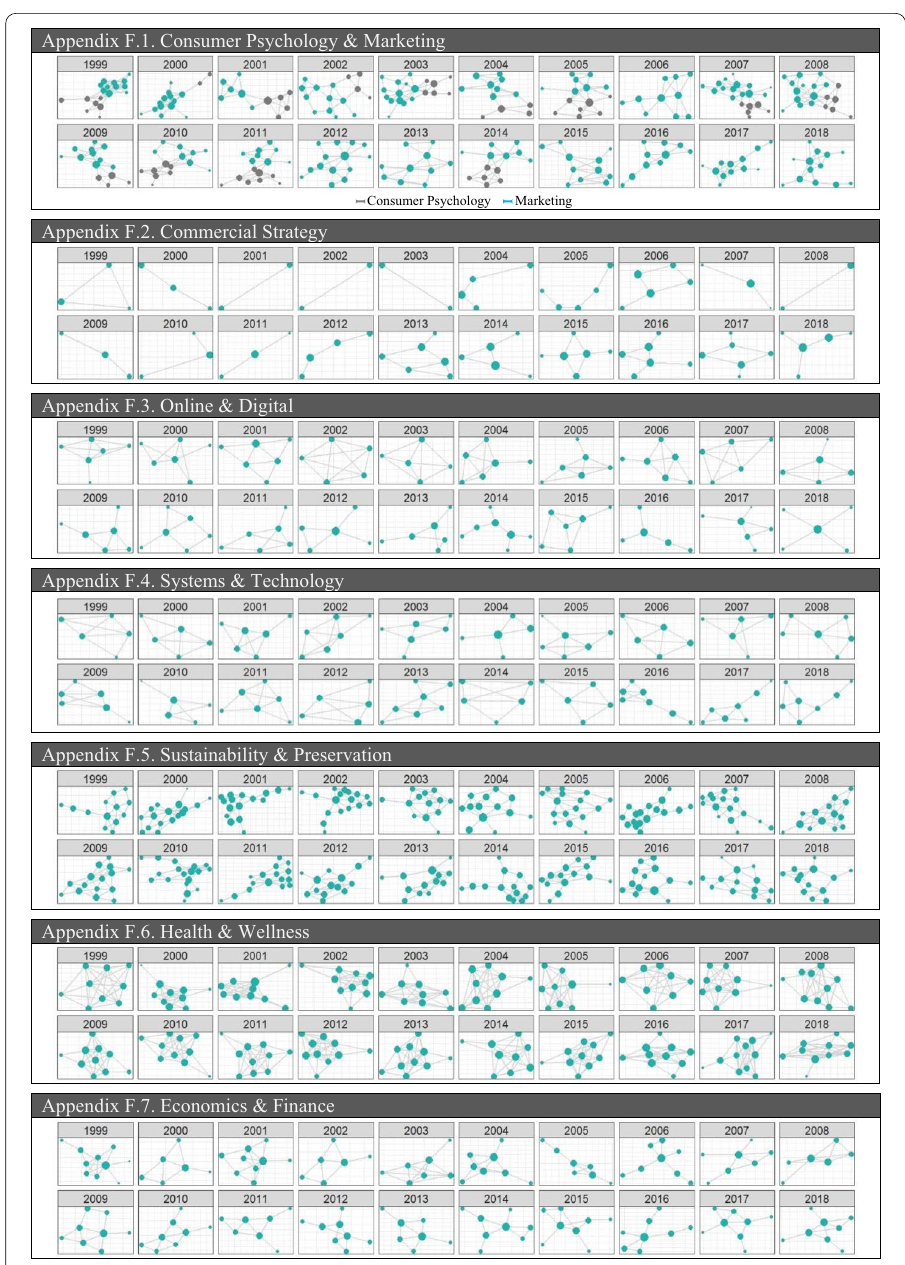
Fig. 11 Topic Community Structure per Subject